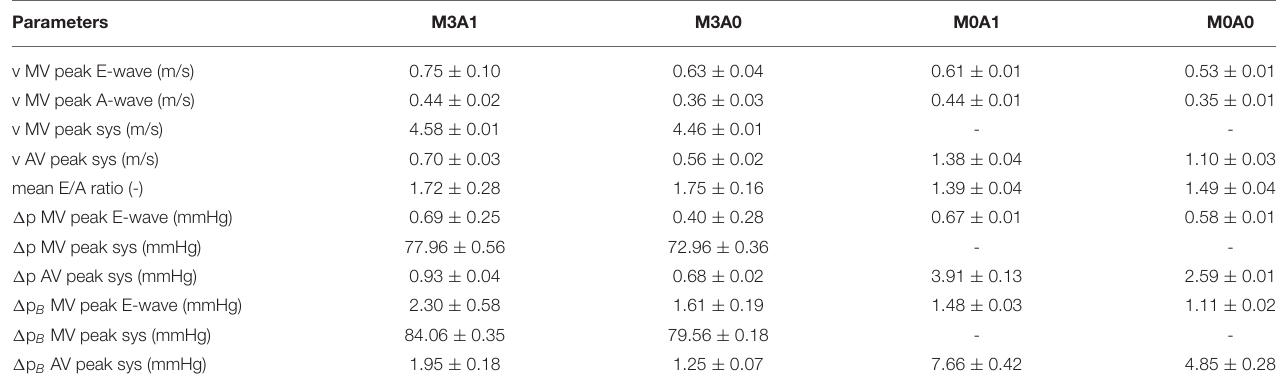
TABLE 3 | Quantitative valve measures of the four representative cases averaged over cycles one to eight.